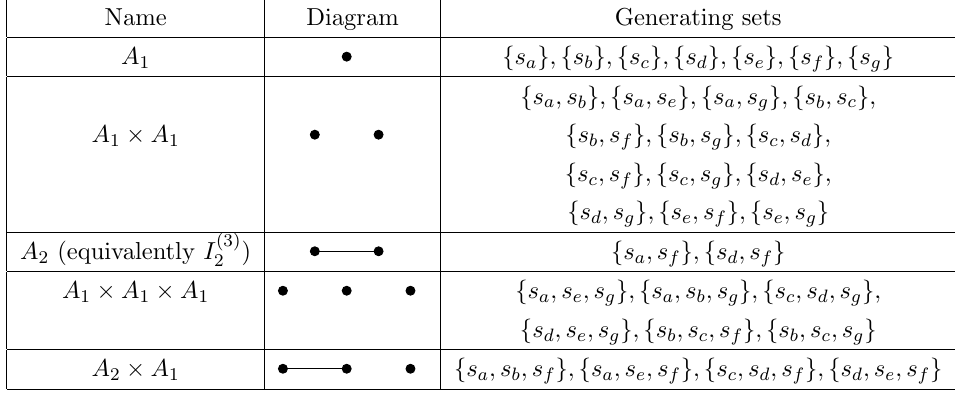
Table 2 . Elliptic subdiagrams of (cid:6)( P 1